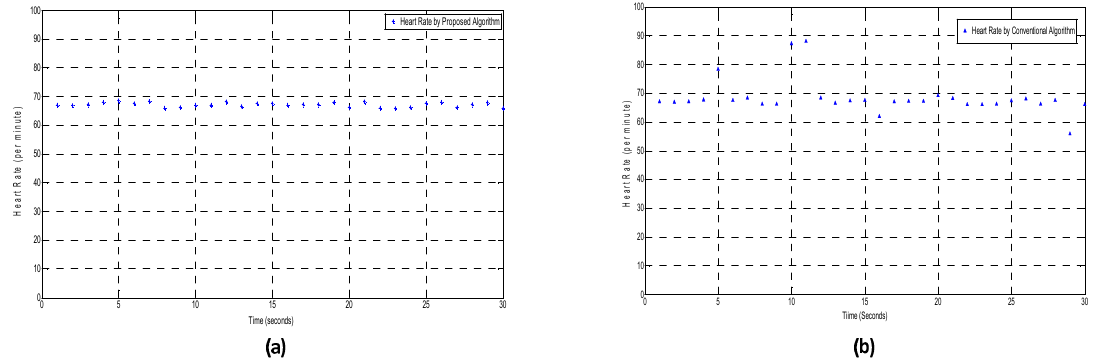
Figure 8. A comparison of the conventional algorithm and the proposed algorithm for heart rate monitoring: ( a ) proposed algorithm result, and ( b ) conventional algorithm result.